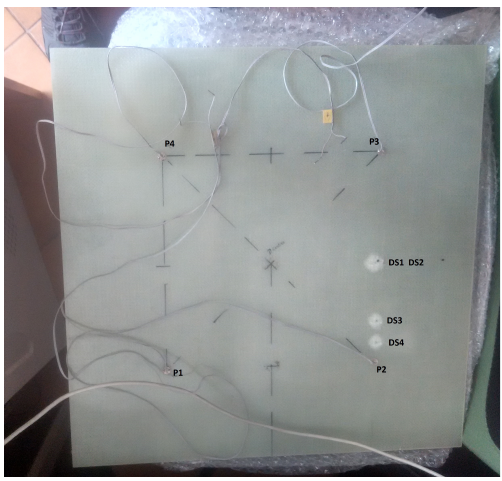
Figure 4. The glass fiber reinforced polymer (GFRP) plate with impact locations. Table 1. Impact damage description on GFRP plate